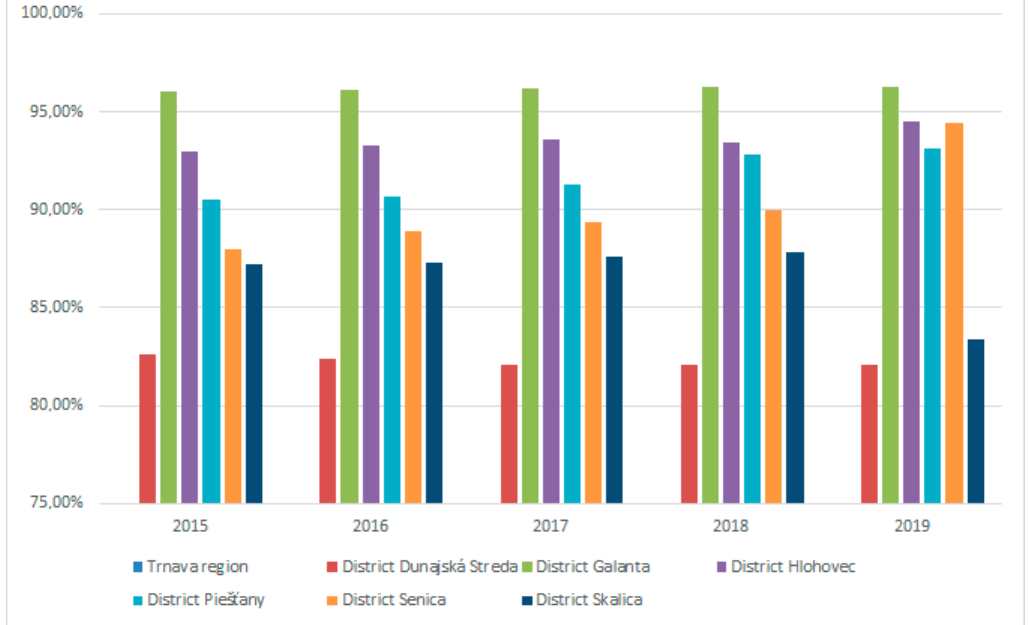
Figure 6. Proportion of population with technical infrastructure- water main—(in %) of the Total Number. Source: Own work based on data from Statistical Office of the Slovak Republic—Datacube [62].